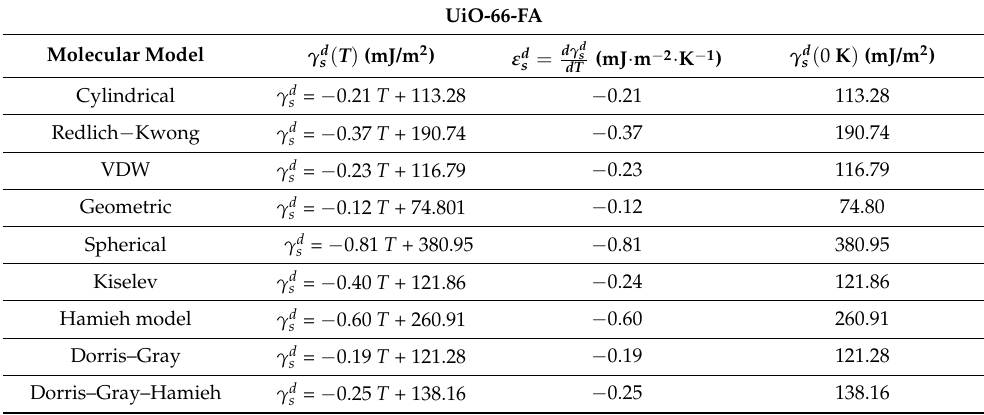
Table 4. Equations γ d s ( T ) of UiO-66-FA surface, the dispersive surface entropy ε d s , and the extrapo- lated values γ d s ( 0 K ) by using the different molecular and thermal models.